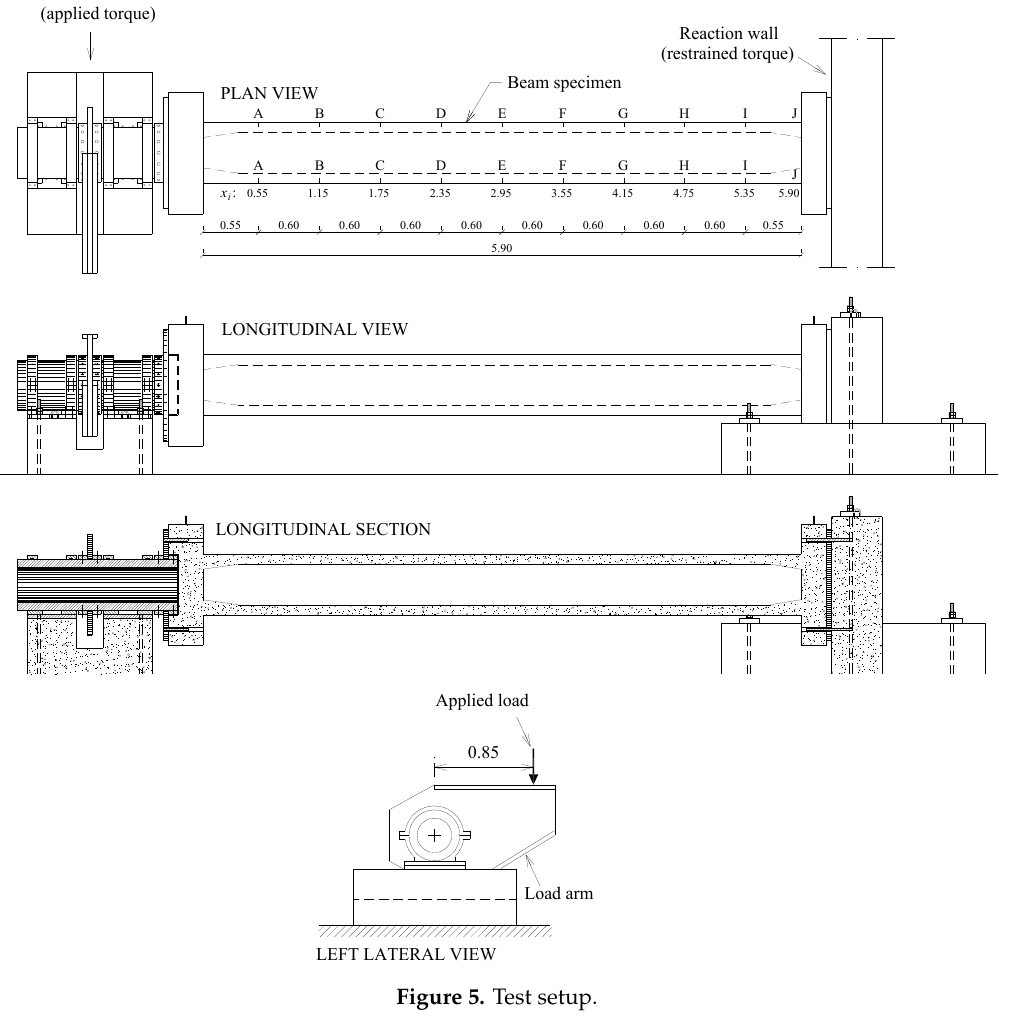
Figure 5. Test setup.